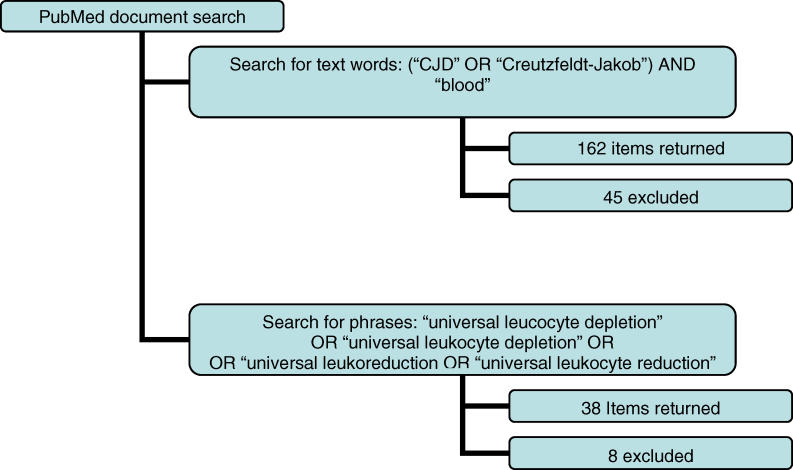
Scientific Publications, Editorials, and ReviewsSearches conducted with results returned and excluded at each step.